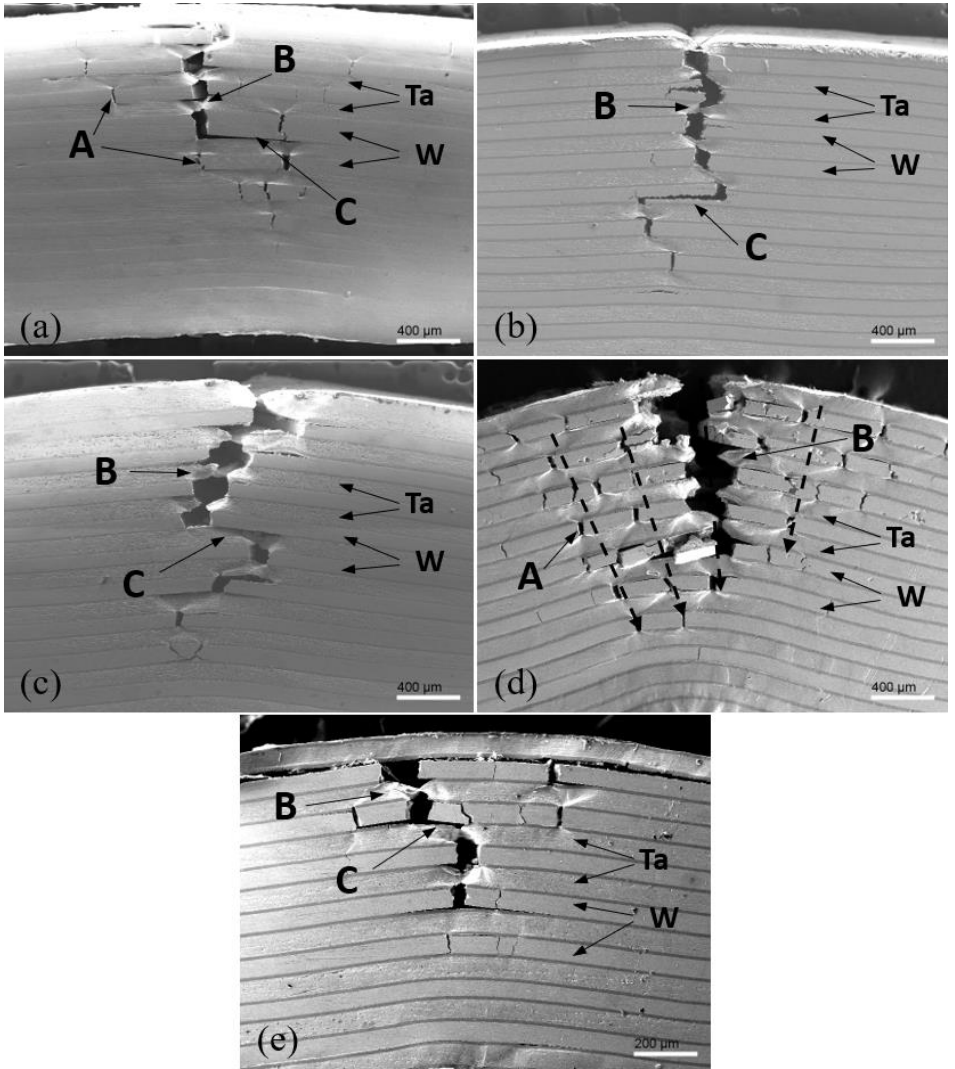
Figure 8. Crack distributions of various W / Ta laminates with di ff erent transition layers, ( a ) W / Ta, ( b ) W / Ni / Ta, ( c ) W / Ti / Ta, ( d ) W / Nb / Ta, ( e ) W / Mo / Ta.